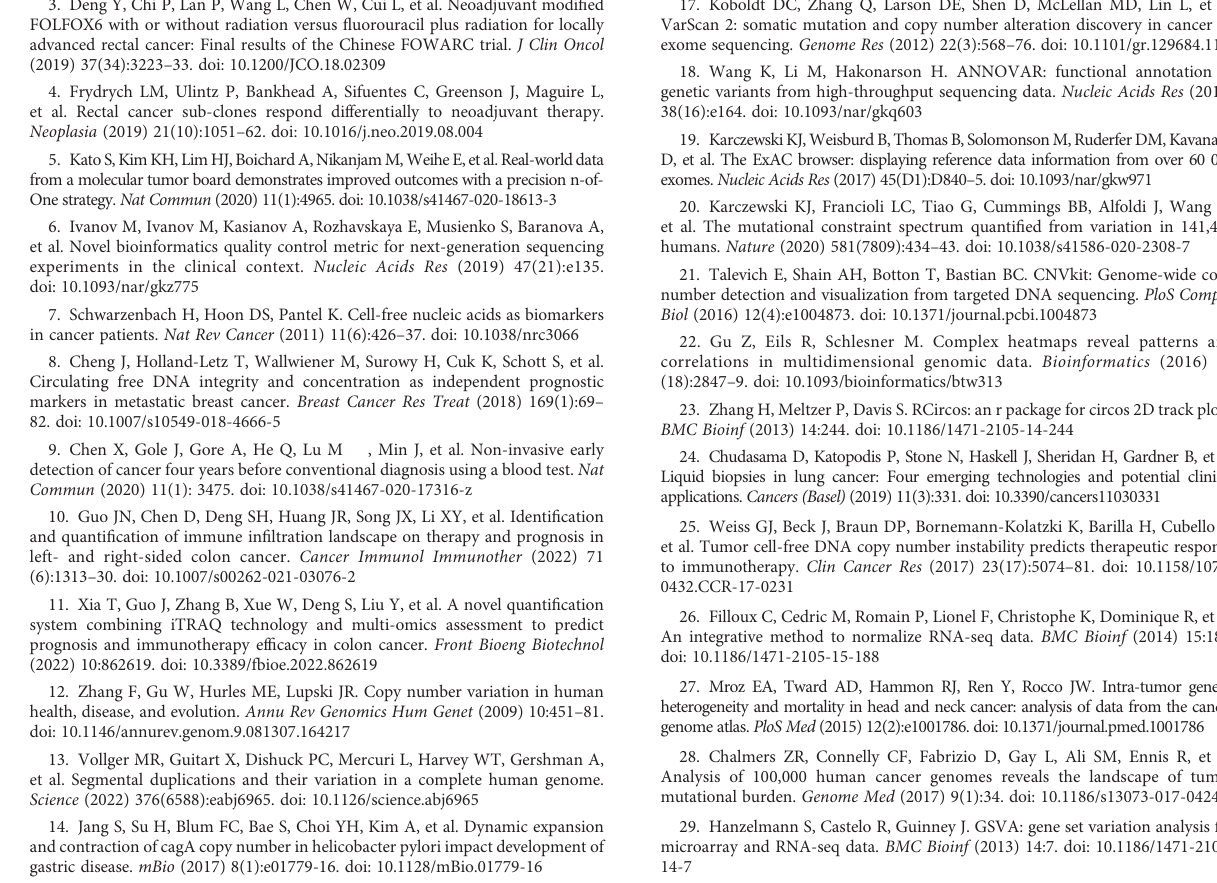
SUPPLEMENTARY FIGURE 1 Correlation analysis in the expression of therapeutic relevant genes with sensitivity of chemotherapy drugs. (A) The increased expression of genes with CNV relatively gained in the poor group was associated with decreased sensitivity to multiple chemotherapeutic drugs, including AURKA and BRAF. (B) In the better group, increased expression of genes with CNV relatively gained was associated with increased sensitivity to multiple chemotherapeutic drugs, including EGFR, SRC, and HSP90AA1.